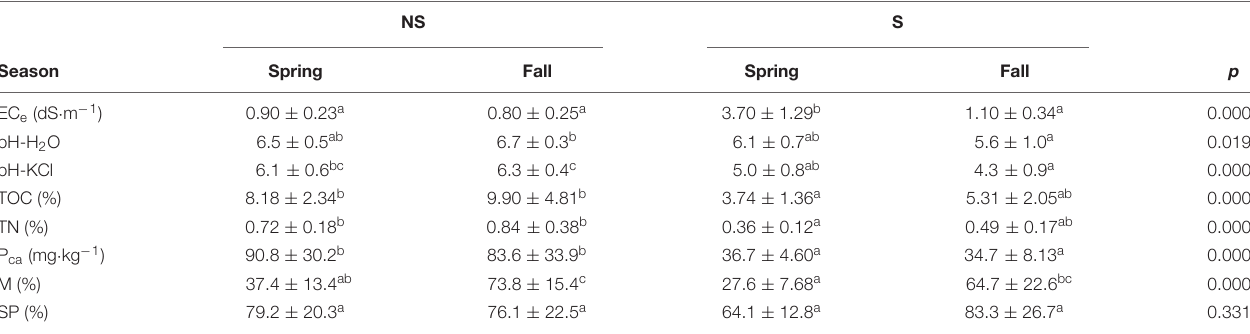
TABLE 2 | Physicochemical and chemical parameters of the studied soils (mean ± standard deviation) and Kruskal–Wallis test with the Dunn post hoc comparisons for analyzed variants (site: NS, non-saline; S, saline; season – fall, spring). NS S